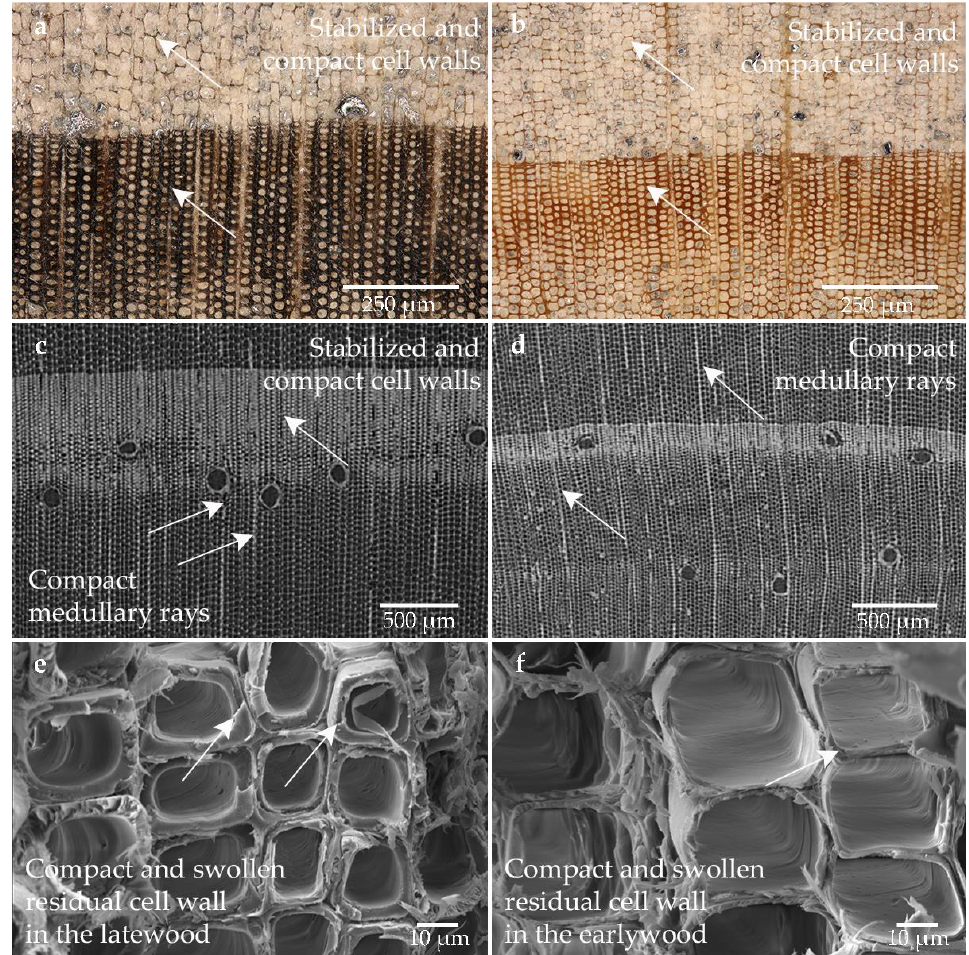
Figure 4. Microscopic wood structure of the sample conserved with the melamine formaldehyde Kauramin 800 (Pi1-K800) ( a ) RLM image from the high degraded area; ( b ) RLM image from the low degraded area; ( c ) CT image of the cross section of the heavily degraded sample; ( d ) CT image of the cross section of the low degraded sample; ( e ) SEM image of the latewood tracheids; ( f ) SEM image of the earlywood tracheids in the heavily degraded area.